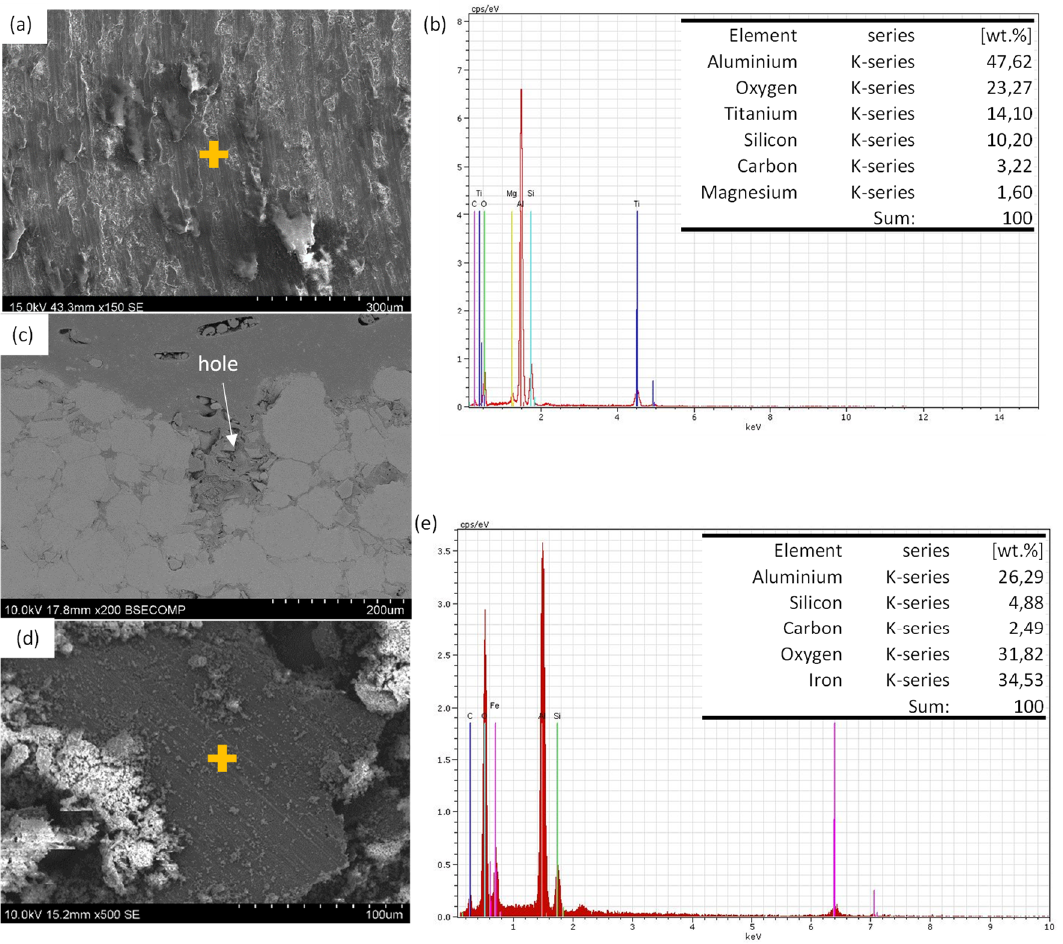
Figure 8. SEM micrographs of wear surfaces of PM sample ( a ) wear surface; ( b ) EDS analysis made on surface shown in ( a ); ( c ) wear mark cross section; ( d ) wear debris; ( e ) EDS analysis made on debris shown in ( d ).